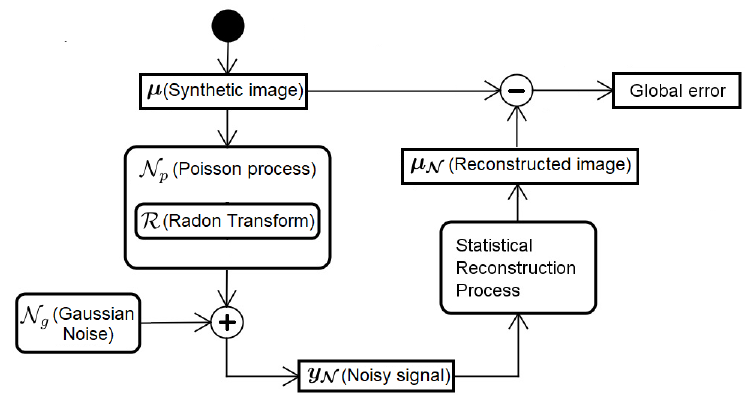
Figure 1. From acquisition to reconstruction and measurement of